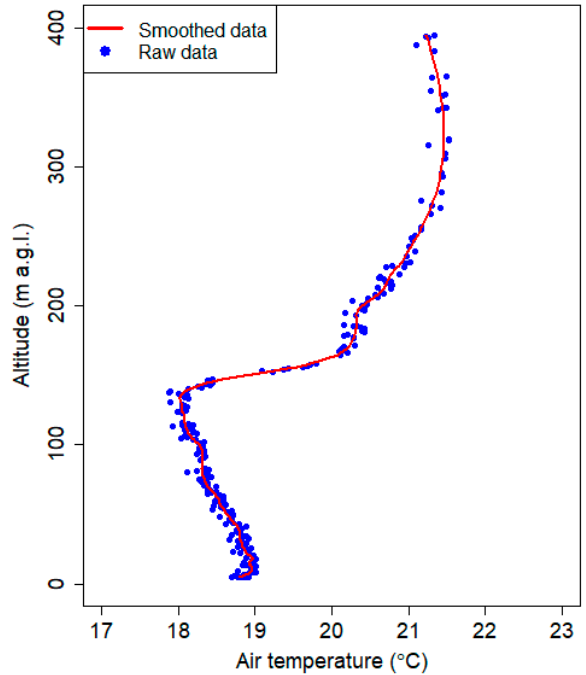
Figure 4. Smoothing data using local polynomial regression and the vertical profile of the temperature measured on 3 August 2018 at 3:23 UTC.